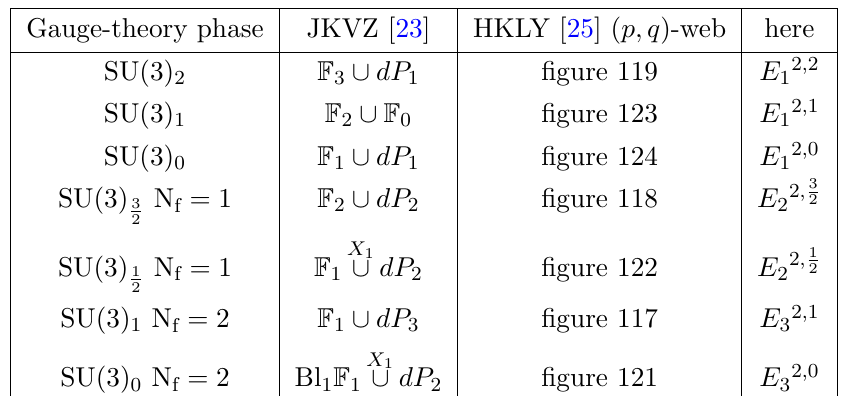
Table 2 . Geometries considered in this paper and their descriptions in references [23] and [25]. Here F n denotes the n th Hirzebruch surface, a degree ( n th del Pezzo surface, and Bl k denotes the blow-up in k points. We refer the reader to section 3 of JKVZ [23] and appendices therein, for explanations of the gluing terminology in the second column. The (cid:12)gure numbers in the third column are ( p; q )-web diagrams in [25] corresponding to the geometries in (cid:12)gure 11, listed in the fourth